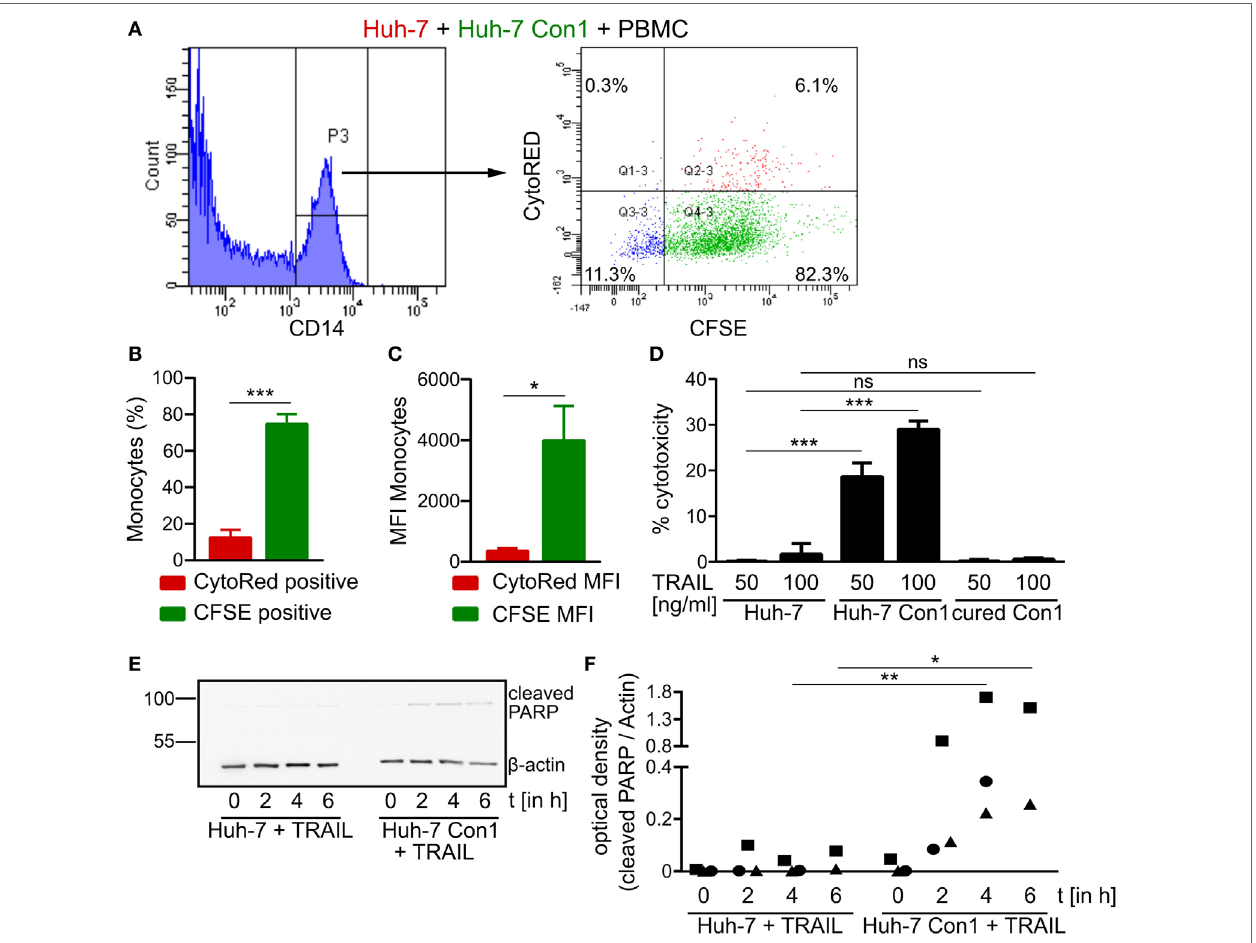
FigUre 7 | Hepatitis C virus (HCV) specific killing by activated peripheral blood mononuclear cells (PBMCs). (a–c) CytoRED stained Huh-7 cells were co-cultured with carboxyfluorescein succinimidyl ester (CFSE) stained Huh-7 Con1 cells and PBMCs overnight. The percentage of CytoRED and CFSE positive monocytes (B) as well as the CytoRED and CFSE mean fluorescence intensity (MFI) (c) of monocytes were measured ( n = 3). (D) Huh-7 cells were incubated with recombinant TRAIL at the indicated concentrations overnight. Supernatants were measured for lactate dehydrogenase (LDH) activity ( n = 3). (e,F) Huh-7 and cells were incubated with recombinant TRAIL (100 ng/ml) for the indicated time points. Poly (ADP-ribose) polymerase (PARP) cleavage was analyzed by Western Blot ( n =